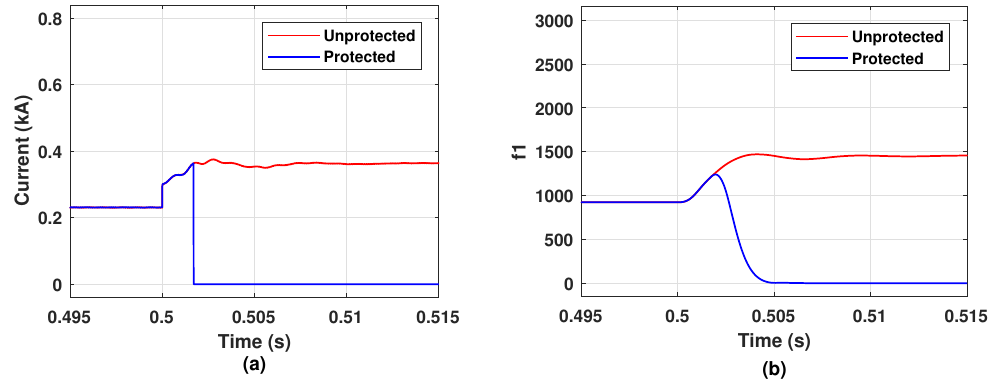
Figure 12. Interrupted and un-interrupted fault current comparison for a fault at F 1 having resistance of 10 Ω , ( a ) actual current ( b ) feature f 1